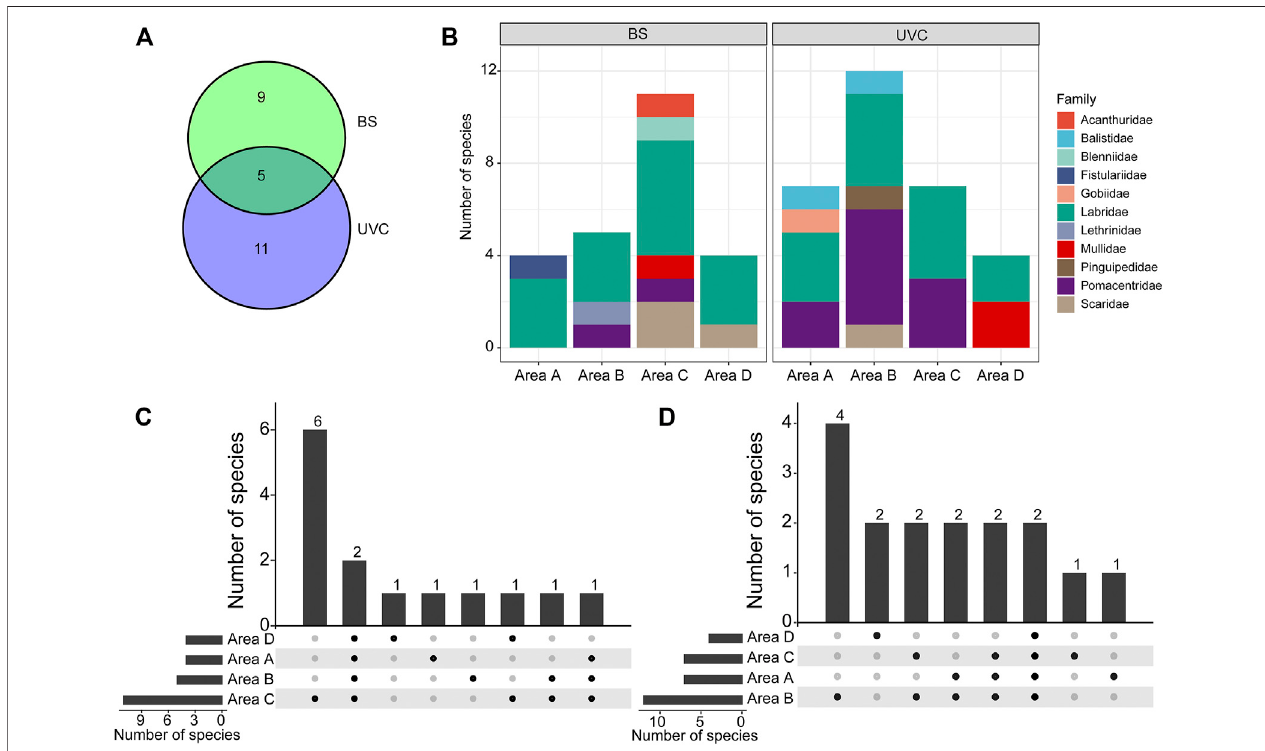
FIGURE2| FishspeciescompositionsinthefoursurveyareasA – DusingBSandUVCmethodsatWestSand. (A) Speciescomposition. (B) Thenumberofspecies at the family level. (C) Species speci fi city and similarity among the four areas using the BS method. (D) Species speci fi city and similarity among the four areas using the UVC method. BS, beach seine; UVC, underwater visual census. The numbers above bars and the solid black spots in (C) and (D) indicate the speci fi city and similarity in the number of species that occurred.